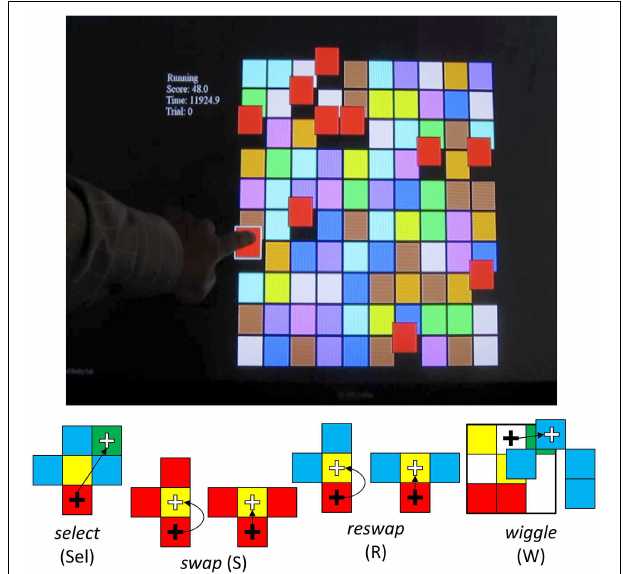
FIGURE 1 | USC-ICT’s “Wiggle” Demonstration Game. Top panel . The game presents users with a 10 × 10 matrix of colored tiles. Users are required to form groups of 3 adjacent sets of the same colored tiles. Doing so provides points and produces a chime. Bottom Panel : Users are constrained in how they can interact with the tiles. They can select a tile by tapping on it, and attempt to move that tile to an adjacent location by tapping on that location. If this move results in a grouping of 3 tiles of the same color, the user has made a swap , which scores points, and causes the entire matrix configuration to change. If the attempted move is to an adjacent location, and does not complete the pattern of three, this is treated like a failed swap attempt, and categorized as a reswap . This activity doesn’t change the interface. Finally, users can also wiggle the tiles on the board by selecting a tile and dragging it to the side. This move causes all tiles of the same color to move with it, revealing spatial relationships between all the tiles of the same color on the board. This function is designed to aid in searching for swap opportunities. Participants are given 10min to complete this